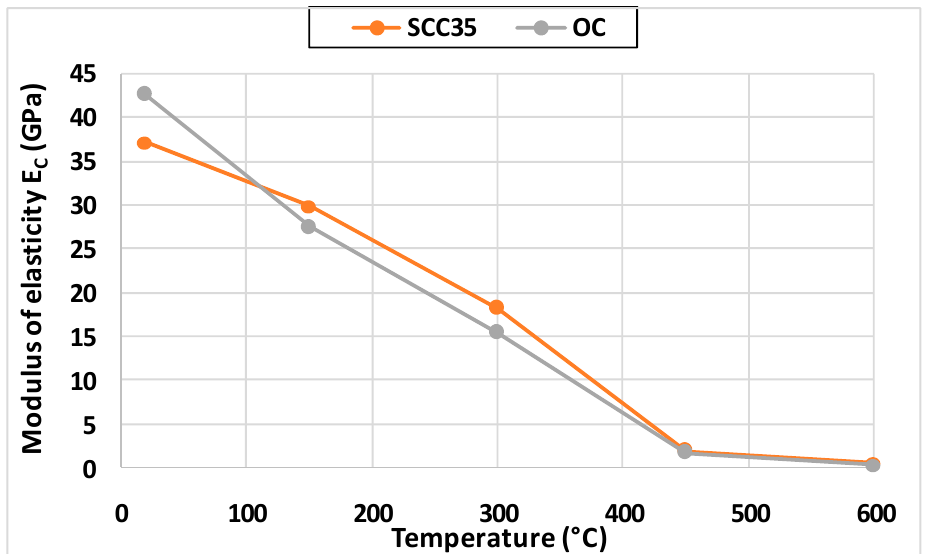
Figure 10. Effect of the heating-cooling cycle on the elastic modulus.